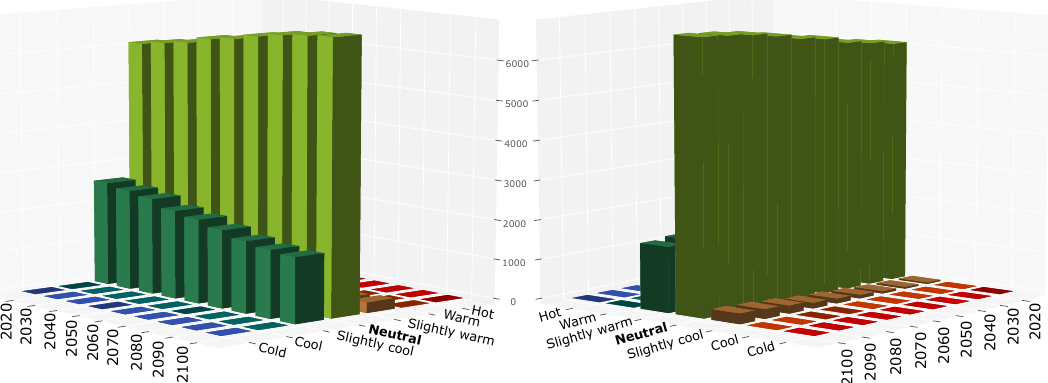
Figure 7. Comfort results taking into account the NBE CTE-79 standard and the Pamplona weather file generated with Meteonorm based on the IPCC scenario